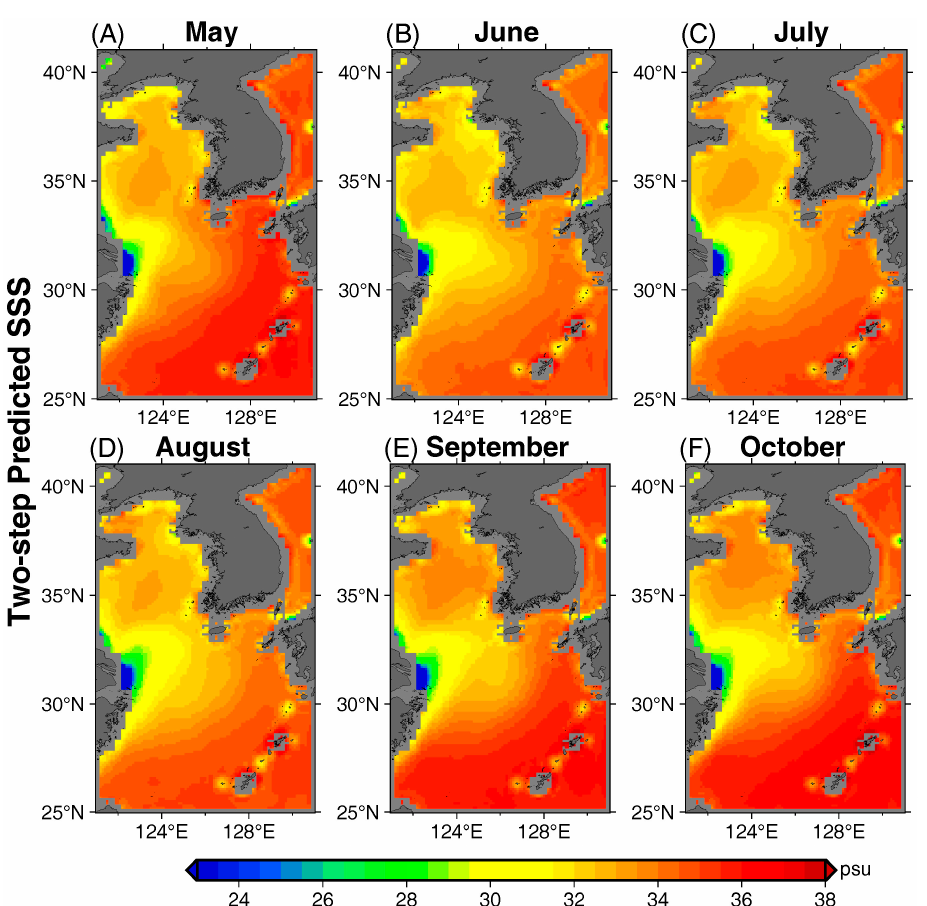
Figure 11. Predicted SSSs over Domain 2 for the two-step prediction experiment from May to Oc- tober.